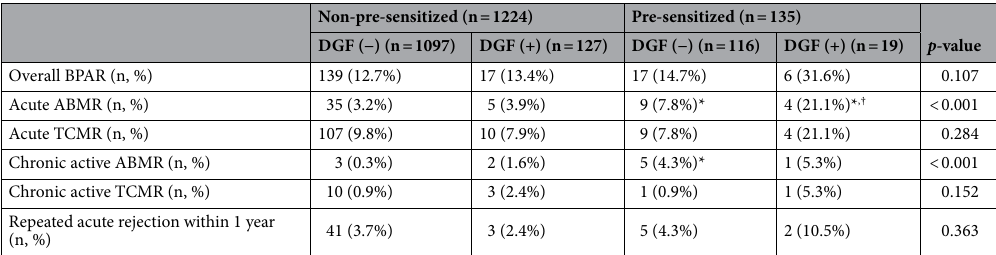
Table 2. Comparison of rejection-related outcomes among the 4 subgroups according to DGF and pre- sensitization status. Categorical variables are shown as number (proportions). DGF delayed graft function, BPAR biopsy-proven allograft rejection, ABMR antibody-mediated rejection, TCMR T-cell mediated rejection. * p < 0.05 compared with non-pre-sensitized-DGF(−) subgroup, † p < 0.05 compared with non-pre-sensitized- DGF(+)